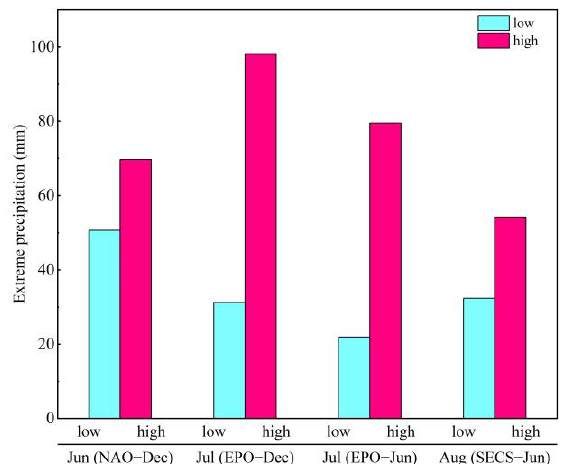
Figure 7. Monthly mean EP in SST anormal years of the MLYR from 1979 to 2010.